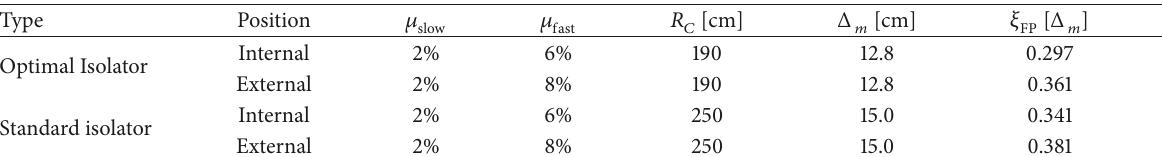
Table 5: Mechanical properties of FPD optimal and standard isolators.